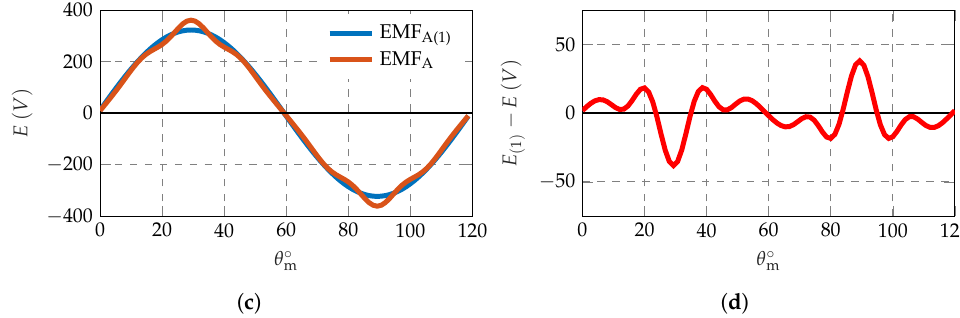
Figure 8. Flux density, electro magnetic force and flux linkage of PRC-6 machine. ( a ) Air gap flux density distribution versus rotor position. ( b ) No-load stator flux linkage versus rotor position. ( c ) Electro-magnetic force versus rotor position. ( d ) Difference between actual and main EMF harmonic versus rotor position.